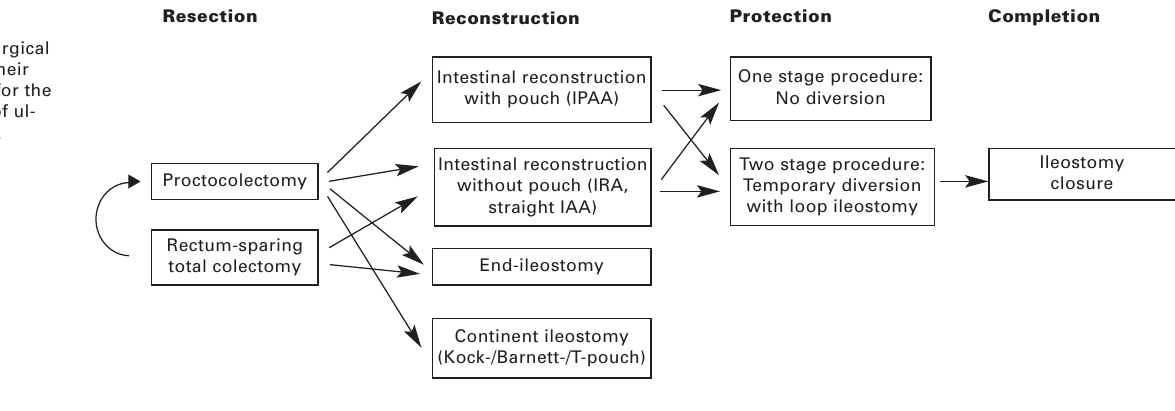
Complex interactions between the ulcer- ative colitis patient and his personal